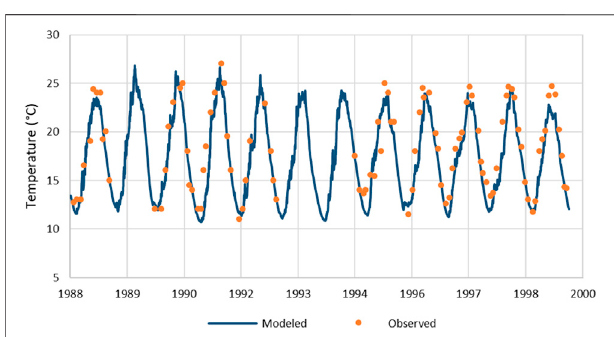
FIGURE 4 | Water temperature comparison between observed and modeled data at the